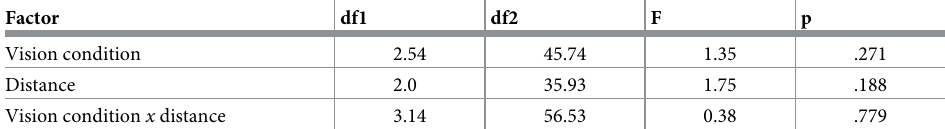
Table 17. Results of the two-factor ANOVA with repeated measures (3 distances; 4 vision conditions) for the vari- able error of predicted putt length. Corrected by Greenhouse-Geisser � . Factor df1 df2 F p Vision condition 2.54